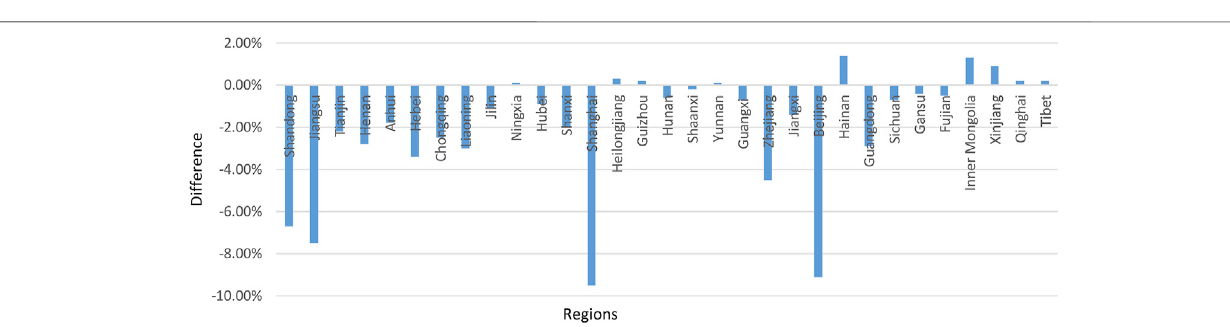
Frontiers in Environmental Science |